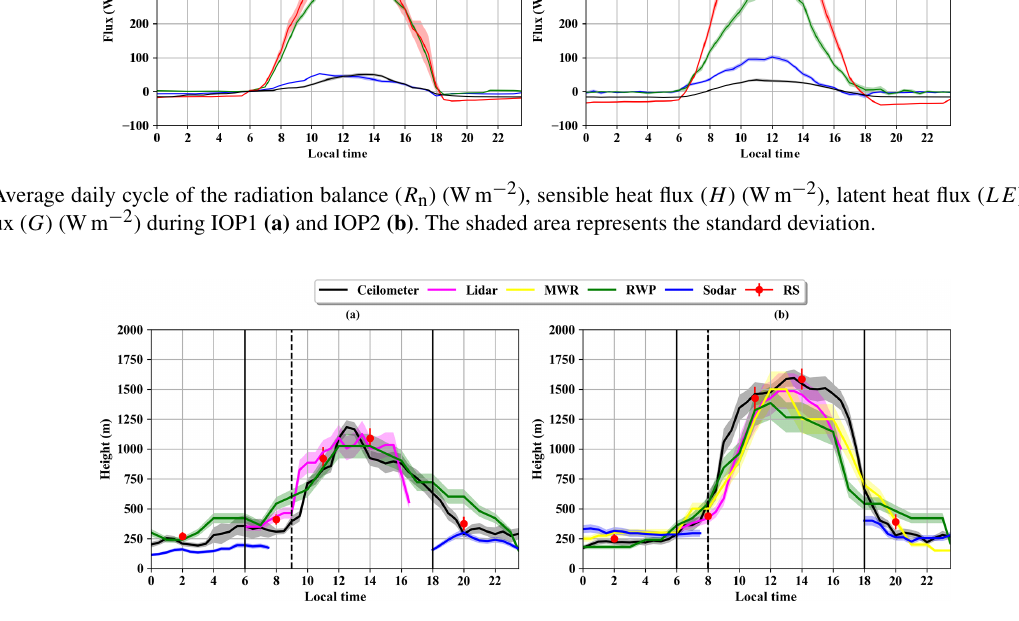
Figure 4. Daily cycle of the height of the PBL during the IOP1 (a) and IOP2 (b) experimental periods. The vertical lines represent sunrise (06:00LT), sunset (18:00LT) (full line) and NBL erosion (dashed line). The shaded area represents the standard